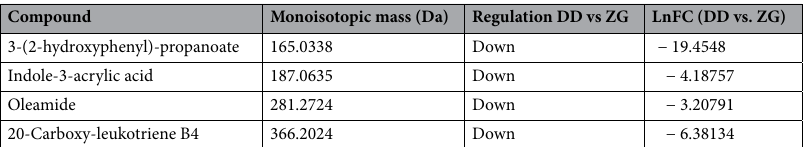
Table 5. Metabolites obtained from LC–MS data (positive mode), that are differentially accumulated in ruminal fluid samples from buffaloes of DD Group (fed a total mixed ratio (TMR)) and ZG Group (fed TMR + 30% of green forage). Identifications were performed by comparing results with known compounds present in a freely available electronic database. Bovine Metabolome Database (BMDB) was used for the identification. Up , up regulated; Down, down regulated. LnFC, Natural logarithm of Fold